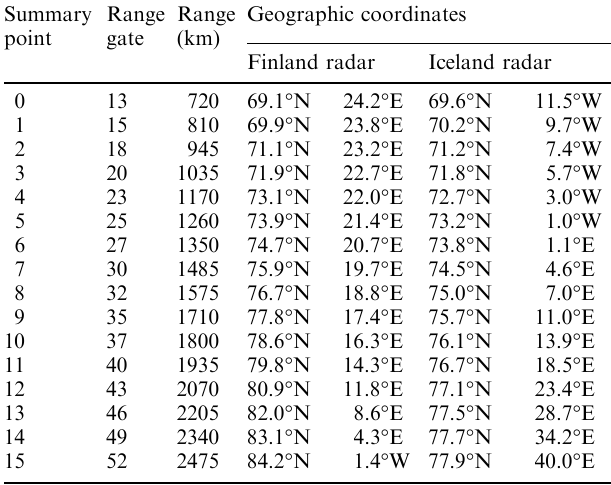
Table 1. The locations of the 16 summary points within the